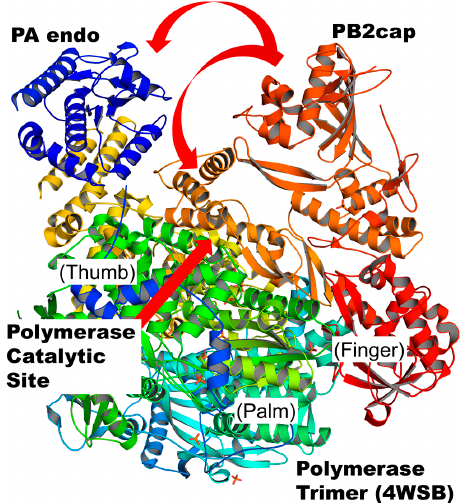
Figure 7. The ribbon drawing of influenza A virus polymerase complex using coordinates from PDB 4WSB [27]. PB2cap is colored in orange, and the PA endonuclease domain is colored in blue. Arrows indicate possible movements of PB2cap induced by cap binding. Regions respective to a right-sided human hand are shown in parenthesis [13,23].